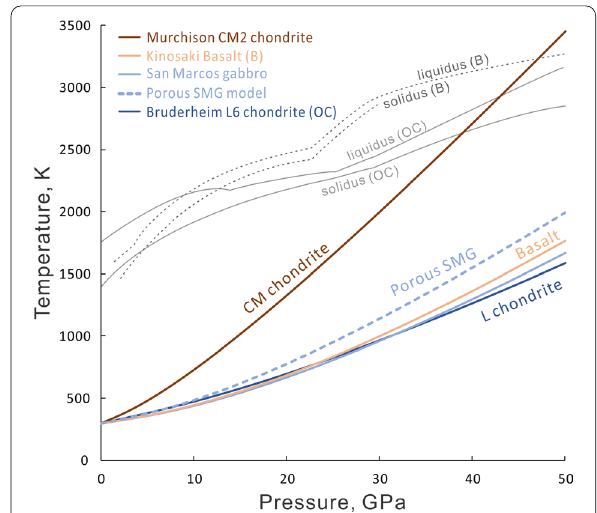
Fig. 3 The shock temperatures of common rocks and meteorites, calculated by the Hugoniot integral approximation, using the parameters in Table 1. SMG is San Marcos gabbro. The representative solidus and liquidus of ultramafic/mafic rocks are for chondrites (OC) from Agee et al. (1995) and basalt (B) from Hirose et al. (1999) and Andrault et al.